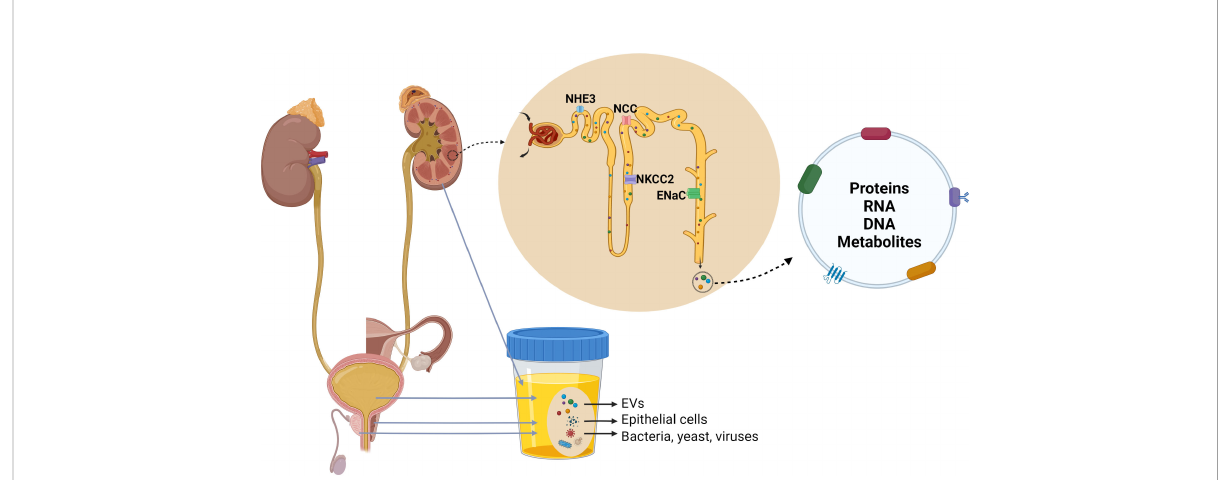
FIGURE 2 Origin and composition of urinary extracellular vesicles (uEVs). uEVs are generally considered to originate from several parts of the urogenital tract, including the kidneys, bladder, prostate in males and utero-vaginal tract in females. Urine can also contain a small quantity of EVs derived from other organs, epithelial cells, bacteria, yeast and viruses. uEVs carry proteins, nucleic acids, lipids and metabolites, and uEVs originating from cell lining nephron lumen contain marker proteins of nephron